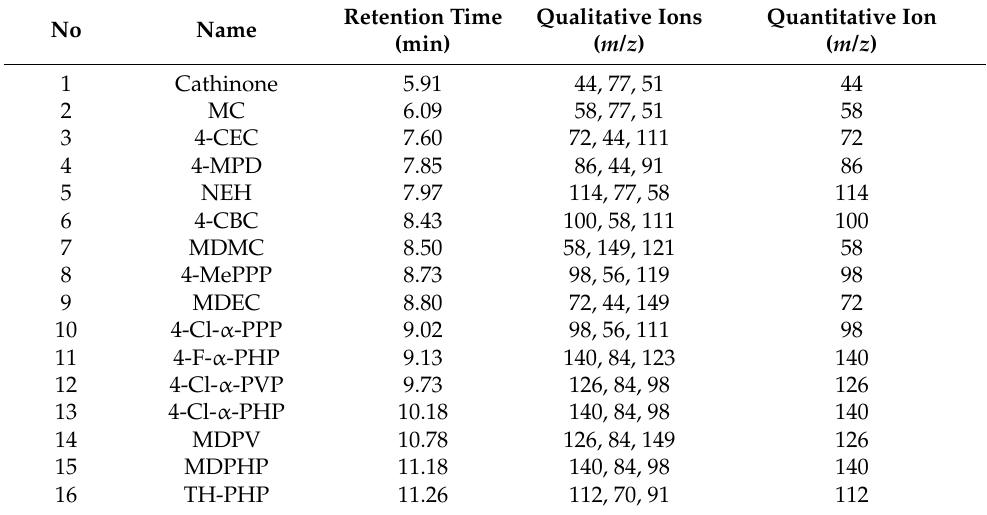
Table 3. Retention times and mass to charge of characteristic ions for 16 kinds of synthetic cathinones.